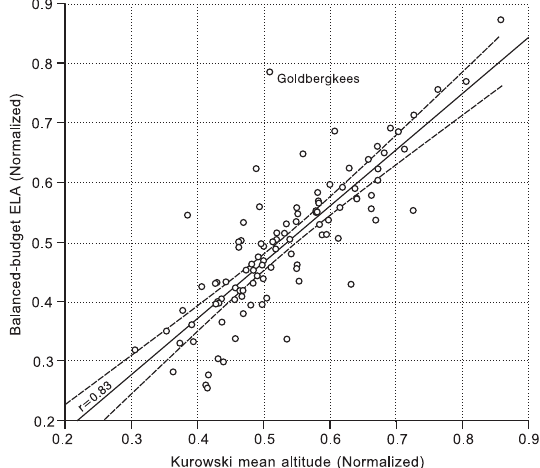
Figure 5. Balanced-budget ELA vs. Kurowski’s mean altitude for 103 glaciers.